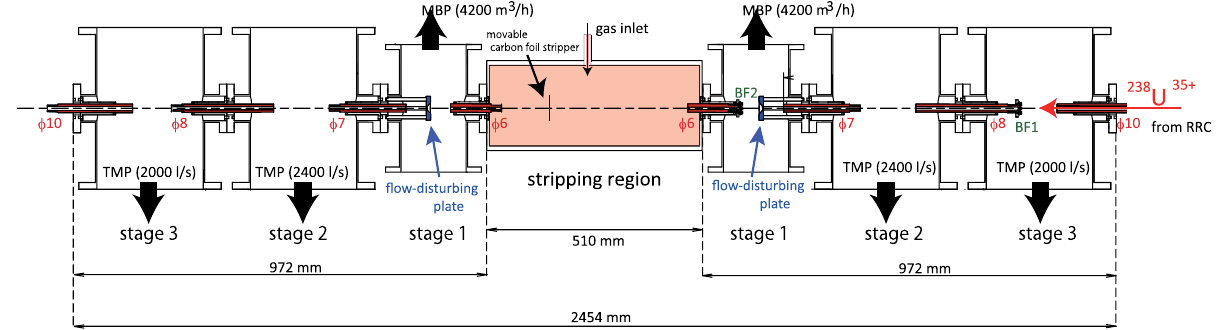
FIG. 2. Cross-sectional view of the 0.5-m charge-stripping system. The system used here consists of two three-stage differential- pumping systems. Flow-disturbing plates are furnished to decouple the gas flows between stages 1 and 2. Beam current detectors with four segmental baffles, BF1–BF2, are attached at the beam entrance of the apertures to monitor the beam loss. The gas inlet line is connected to the gas-handling system. In addition, the target chamber is equipped with a foil changer for the carbon-foil stripper.